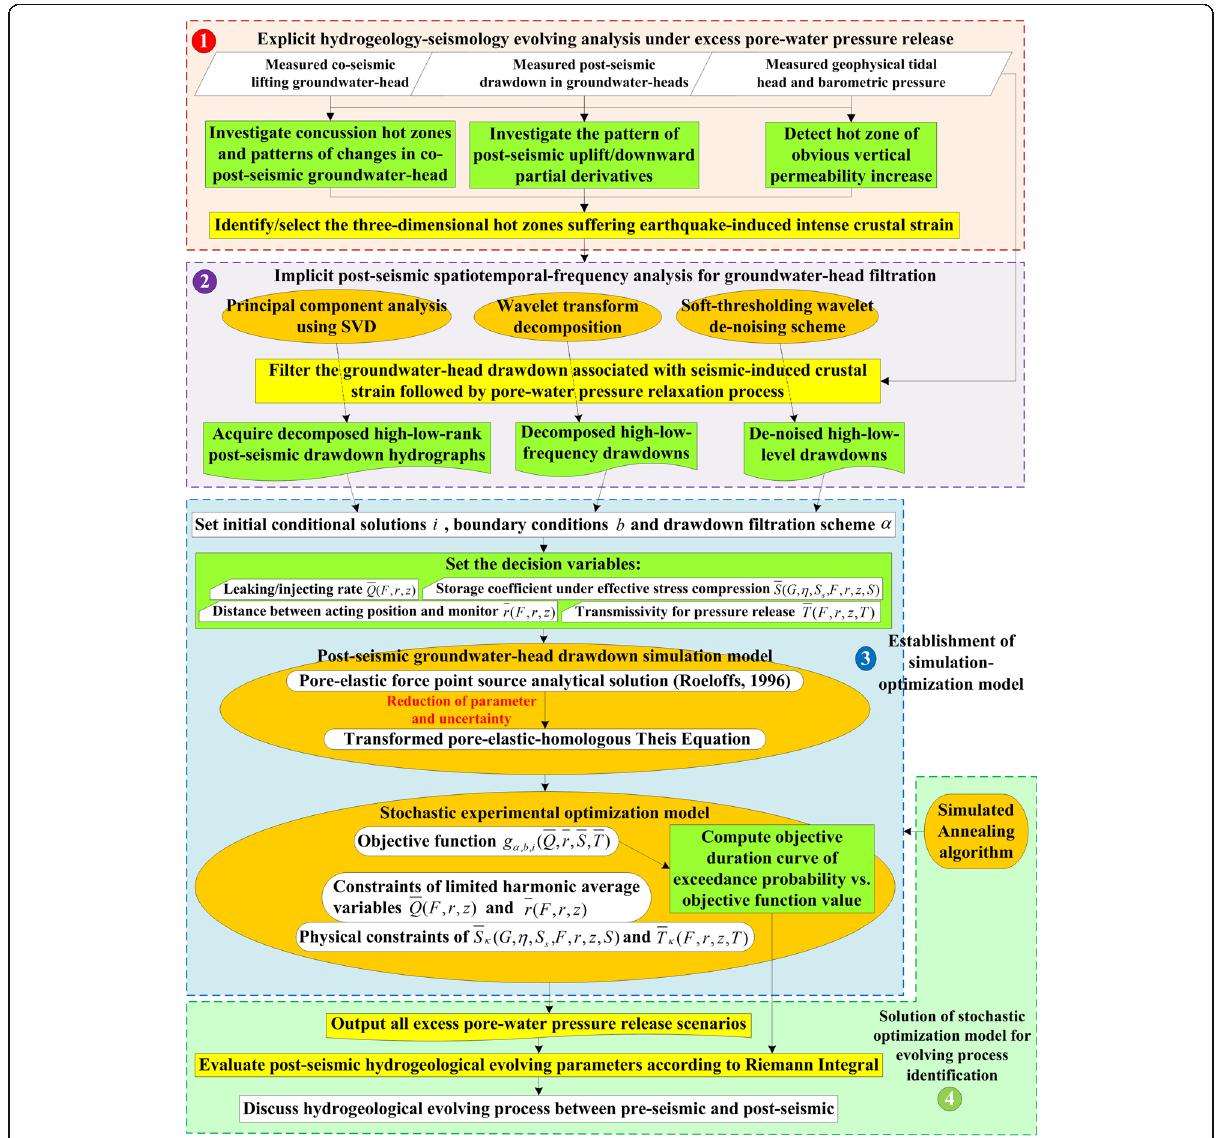
Fig. 1 Flowchart of the research